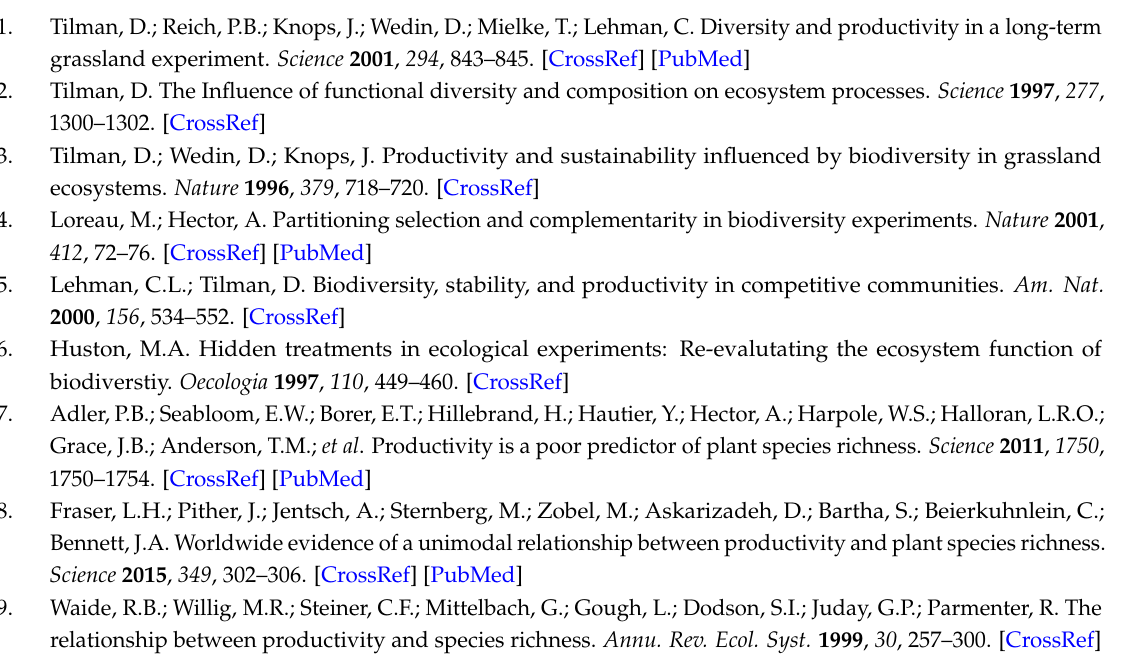
summarized in Table S2. Table S2: Species abbreviations and identities in Table